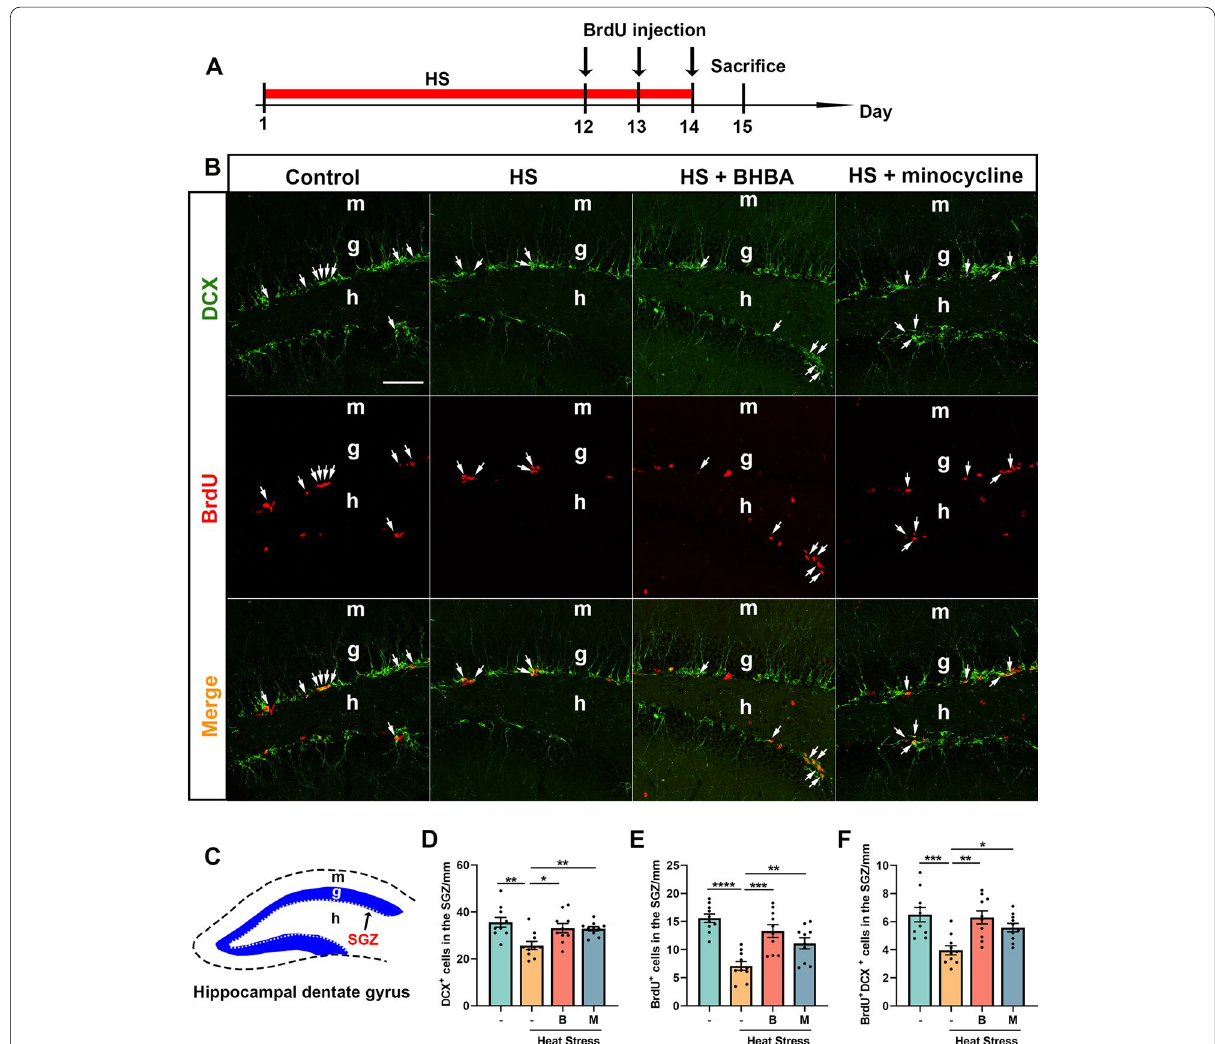
Fig. 3 BHBA administration increases the proliferation of NSCs in the heat stress-treated hippocampal dentate gyrus. A Timeline of the experimental procedure. B Representative images are shown depicting the dentate gyrus sections immunostained with anti-BrdU (red) and anti-DCX antibodies (green). White arrows indicate BrdU + DCX + double-labeled newly generated neurons in the dentate gyrus. C Schematic illustration of the dentate gyrus. The white dashed line at the border between the hilus and the GCL represents the SGZ. D - F Quantitative analysis of DCX + cells ( D ), BrdU + cells ( E ) and BrdU + DCX + double-labeled cells ( F ) in the dentate gyrus. Compared with the control group, the density of DCX + , BrdU + and BrdU + DCX + cells decreased significantly in the heat stress-treated mice. Administration with BHBA or minocycline increased the densities of these cells. Scale bars 50 μm. All data analyses were performed using one-way ANOVA with Tukey’s post-test. Data are represented = as mean SEM. D‑F n 10 from 5 mice. * p < 0.05, ** p < 0.01, *** p < 0.001, **** p < 0.0001. B, BHBA; g, granule cell layer; h, hilus; HS, heat stress; m, ± = molecular layer; M, minocycline; SGZ, subgranular